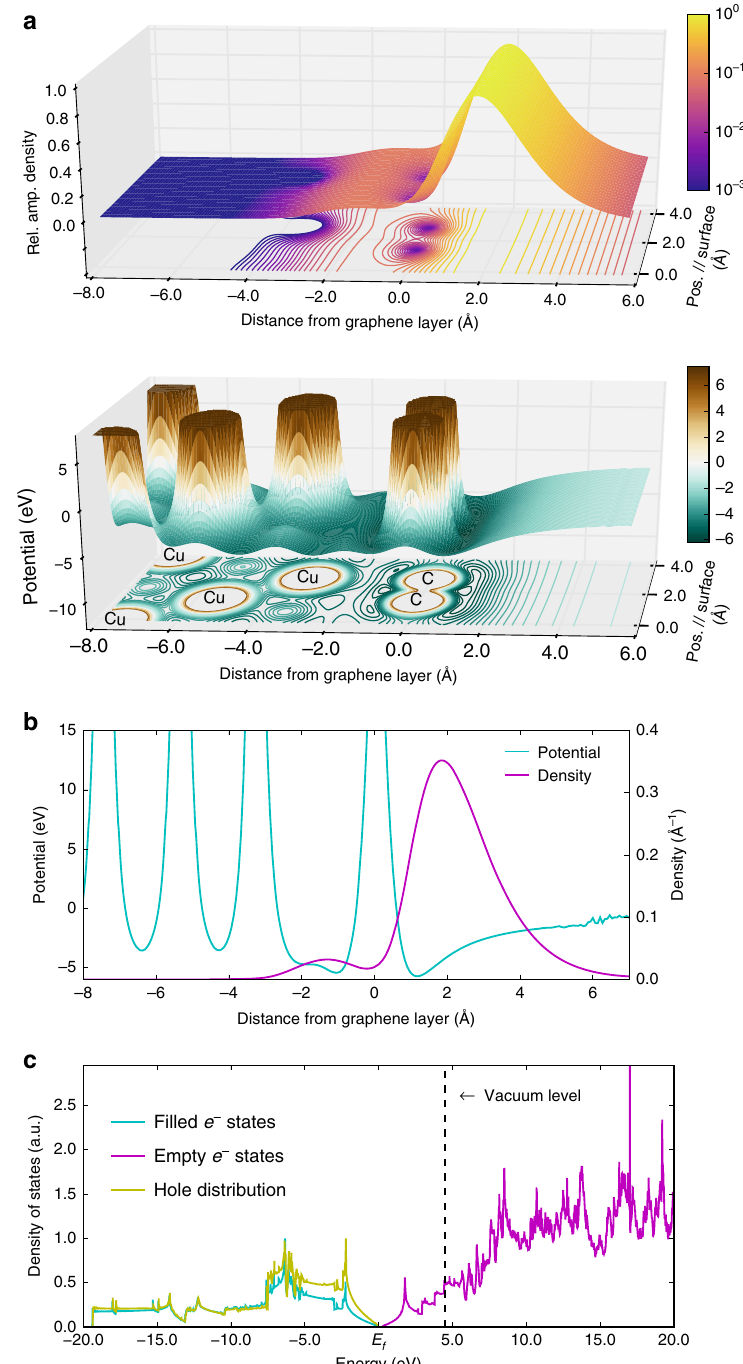
Figure 3 | Results of theoretical calculations. ( a ) Cut through the ground-state positron probability density (top panel) and the potential experienced by the positron near the top atomic layers (bottom panel) along a C–C bond on single layer graphene (SLG) on a Cu (111) substrate (The (110) plane of the unit cell is shown in the Supplementary Fig. 1). Our result shows that the positron is localized predominantly in its image potential well at the vacuum side of the graphene layer, giving signals almost exclusively from the SLG. The 2D contour plot of the potential in the bottom panel shows the position of the Cu and C atoms. ( b ) One-dimensional plot of the potential (turquoise) and the positron density (purple) averaged over the xy plane. It can be seen in this plot that the positron overlap with Cu atoms is small compared with the overlap with the C atoms. As a consequence, most of the annihilation and annihilation induced signal is due to the graphene layer consistent with our experimental results. ( c ) Density of the electronic valence (turquoise) and conduction (purple) states. The vacuum level is indicated by the dashed line. The yellow curve shows the calculated distribution of annihilation induced holes that initiate the VVVAuger process (the distribution of electronic valence states and the distribution of hole states have been scaled to agree at the peak). The calculations show that the distribution of annihilation-induced holes closely resembles the valence band density of states due to the fact that the positron partial annihilation rate is relatively constant for states in the valence